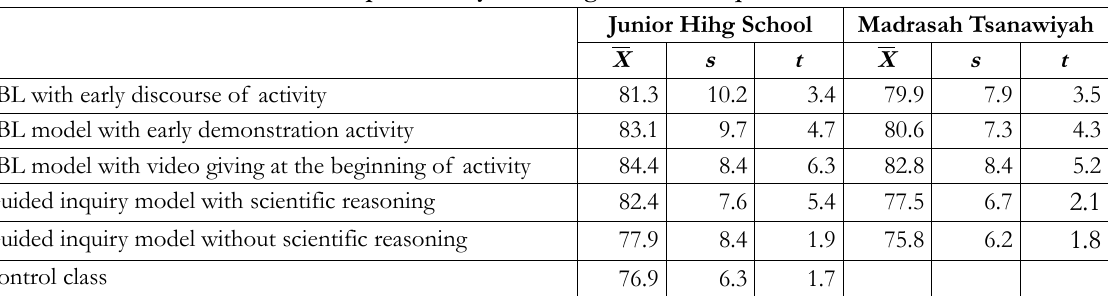
Table 2. Differences test the ability of each